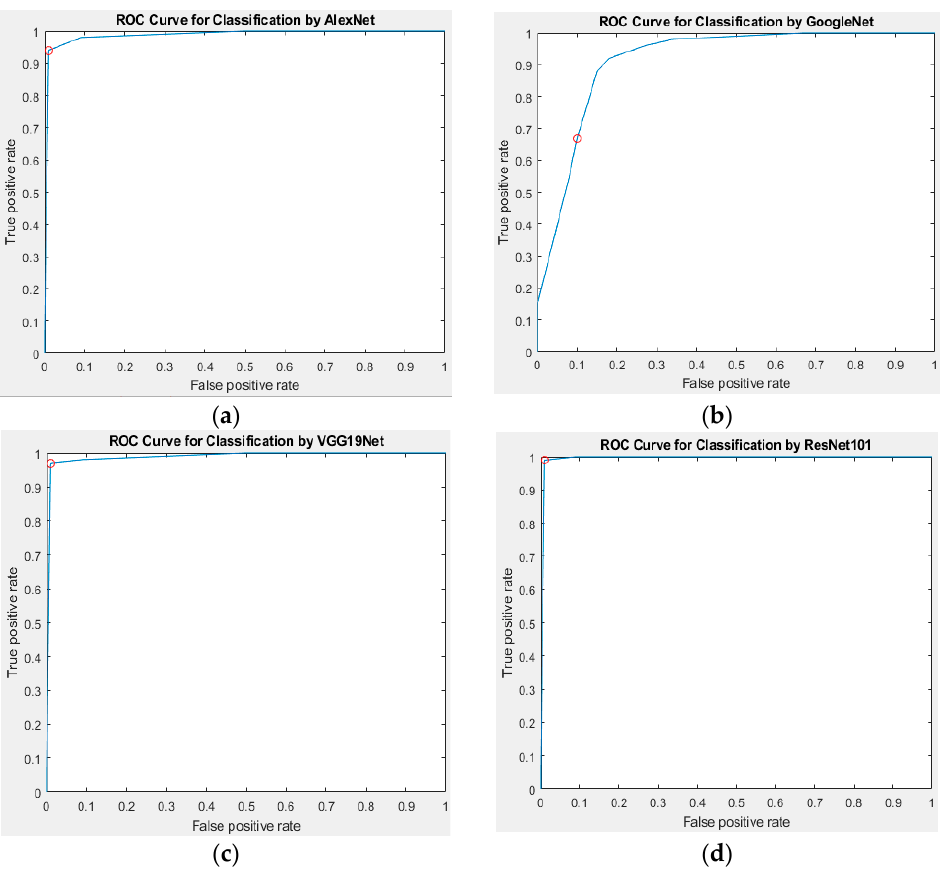
Figure 16. ( a ) ROC graph of AlexNet architecture. ( b ) ROC graph of GoogleNet architecture. ( c ) ROC graph of VGG19Net architecture. ( d ) ROC graph of the ResNet101 architecture.